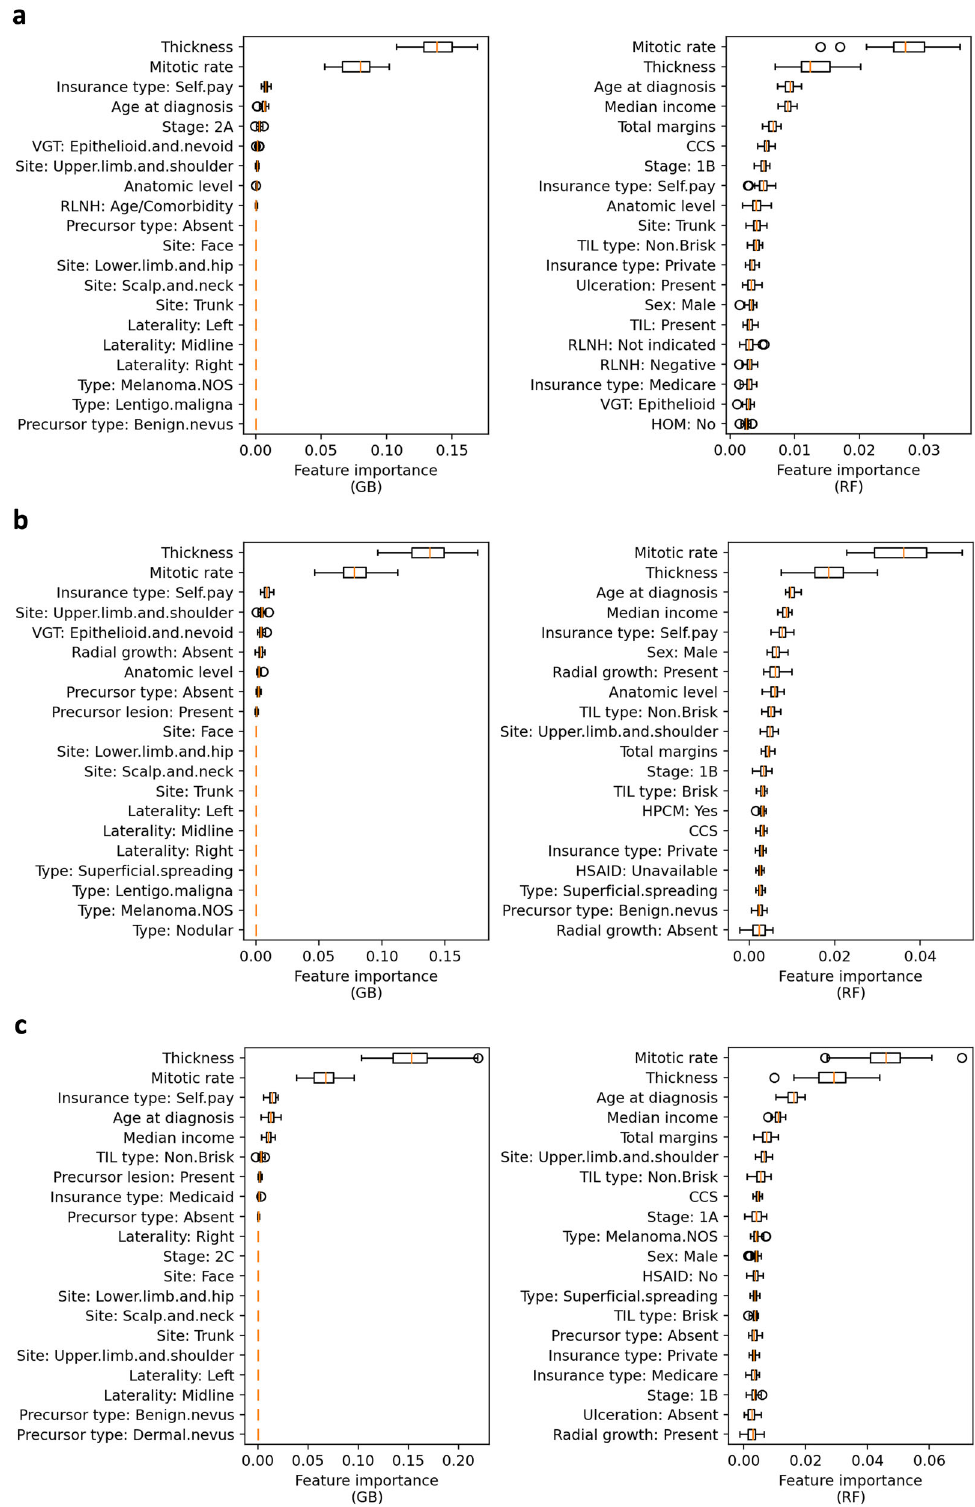
Fig. 5 Feature importance in recurrence classi fi cation by RF and GB models. a The 20 most important features when experimenting on the original cohorts. b The 20 most important features when experimenting on the core complete cohorts: negative or not indicated regional lymph node histology, known mitotic rate, and known ulceration. c The 20 most important features when experimenting on the complete cohorts: negative or indicated regional lymph node histology, known median income, and all tumor features available. The box extends from the fi rst quartile to the third quartile of the feature importance values for each feature, with a line at the median. The whiskers extend from the box by 1.5x the interquartile range. Flier points are those past the end of the